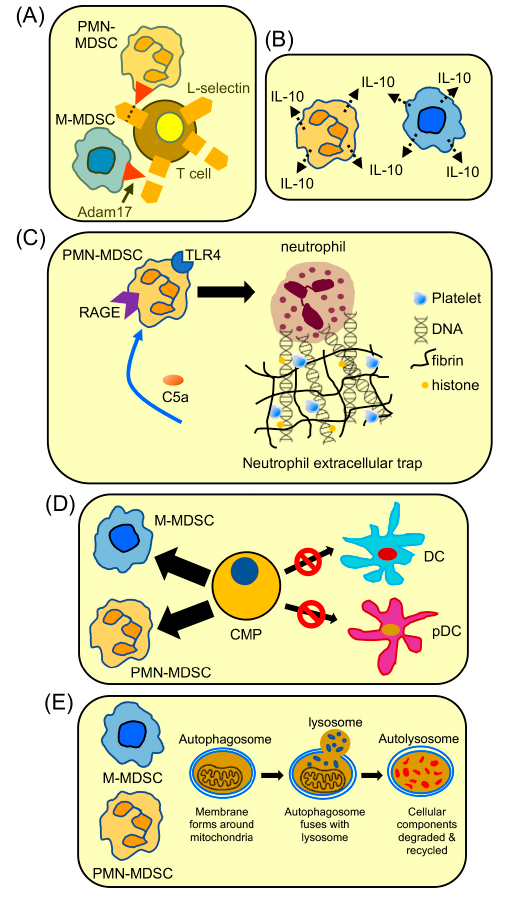
Figure 5. HMGB1 drives the accumulation and function of MDSCs. ( A ) Activation of T cells within lymph nodes requires that naive T cells express L-selectin so they can extravasate from the circulation and enter lymph nodes. MDSCs impair this process through their plasma membrane expression of ADAM17, an enzyme that cleaves L-selectin. L-selectin cleavage is exacerbated by HMGB1-activated MDSCs. ( B ) HMGB1 enhances MDSC production of IL-10. ( C ) HMGB1 increases PMN-MDSC expression of TLR4 and RAGE, and these MDSCs drive NETosis. MDSC-driven NETosis and MDSC migration are stimulated by complement C5a. ( D ) HMGB1 drives the differentiation of common myeloid progenitor cells (CMPs) toward MDSCs at the expense of dendritic cells (DCs) and plasmacytoid DCs (pDCs) resulting in a decrease in DCs and pDCs. ( E ) HMGB1 drives MDSC autophagy and survival.